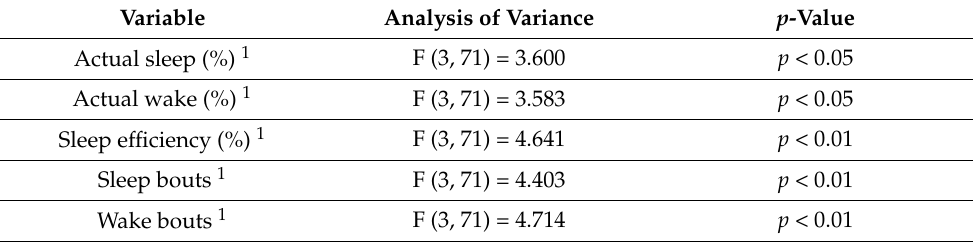
Table 3. Statistical comparison of sleep parameters according to gender and age. Variable Analysis of Variance